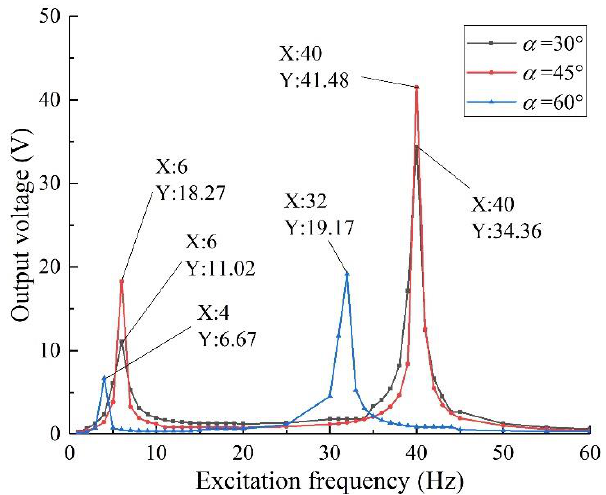
Figure 7. Harvesting performance of specimens with different oblique angles.